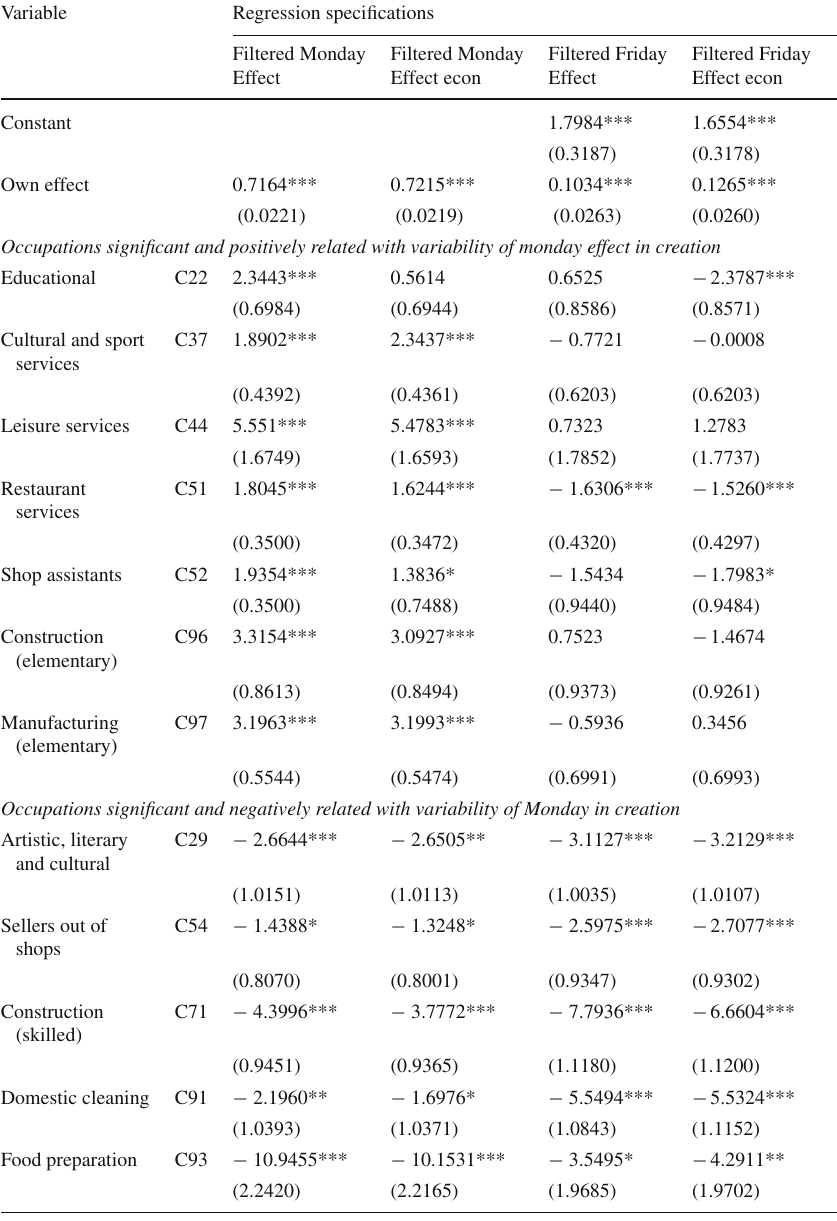
Table 4 Linear relations between daily share of contracts in the different occupations and variability of either monday or friday effect in employment creation (with or w/o economic dummies)